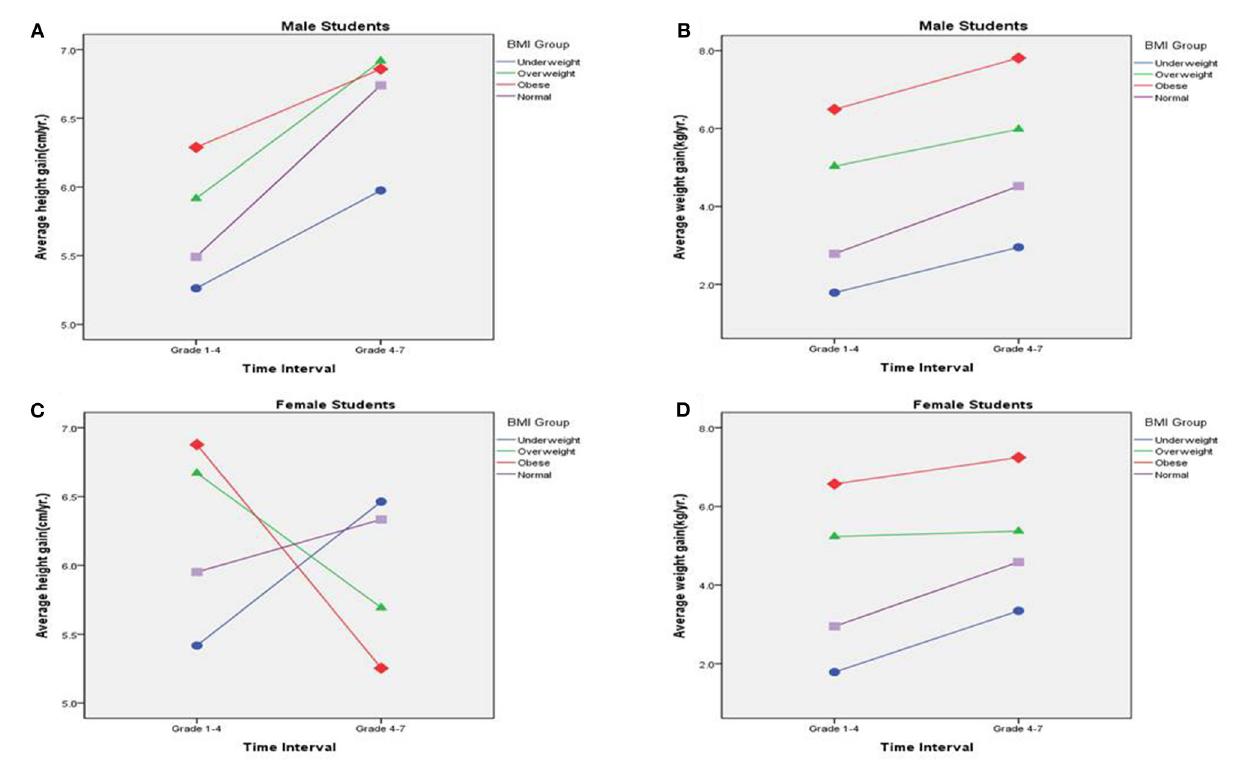
FIGURE 2 | (A–D) Results of repeated measures analysis of variance for male and female